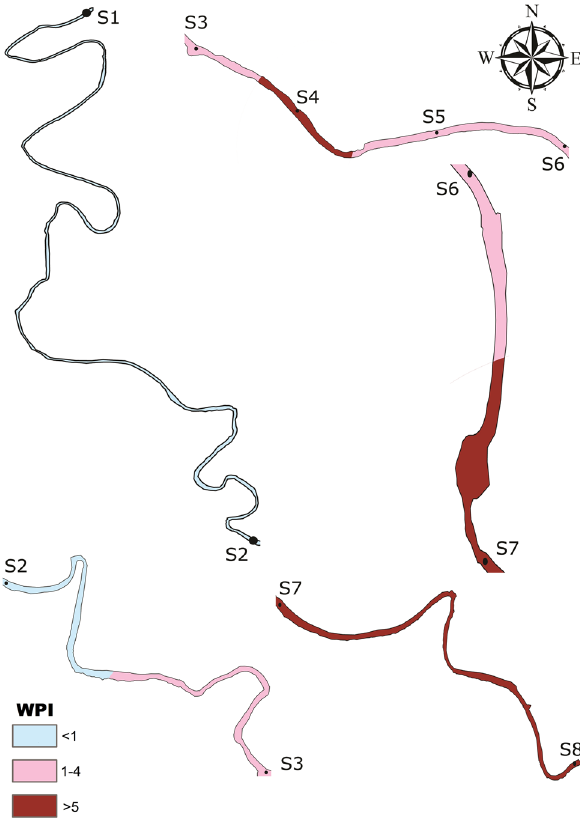
Fig. 5 Spatial variation of WQI in various stretches of River